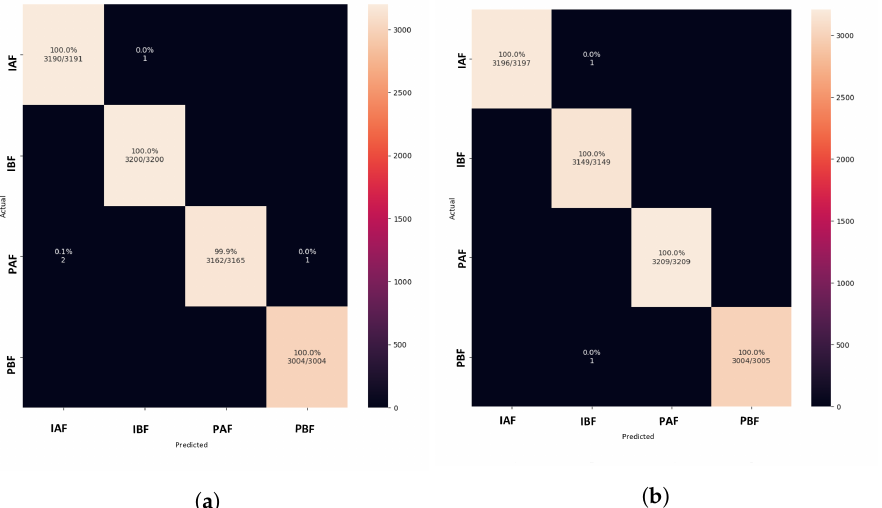
Figure 18. Confusion matrix of proposed DISubNet models for learning rate = 0.001. ( a ) DISubNetV1. ( b ) DISubNetV2.